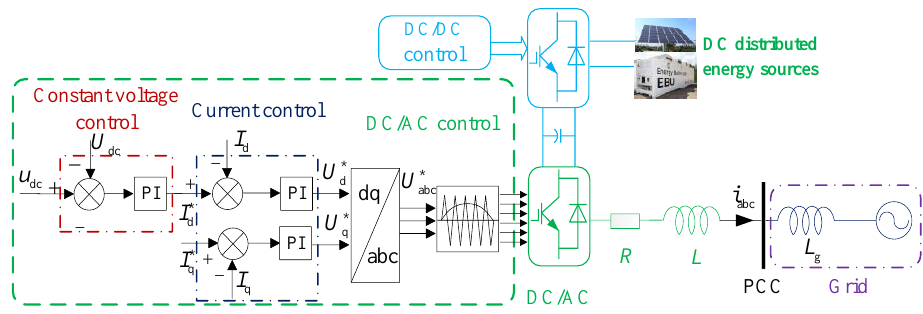
Figure 6. Control block diagram of the grid-tied inverter.